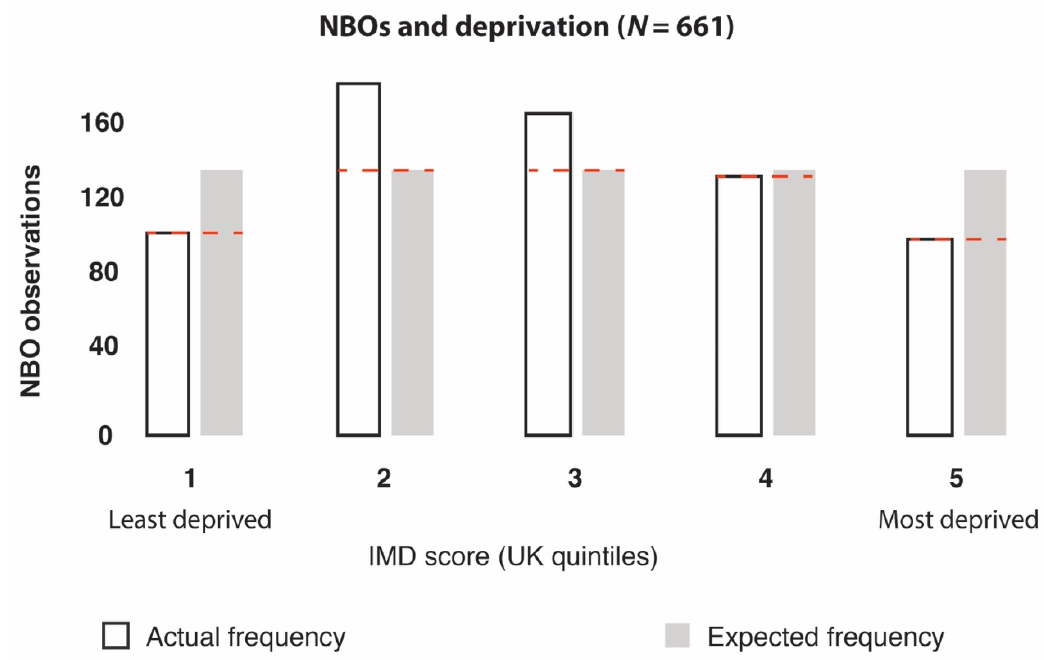
Figure 12. Output of X 2 results: The frequencies of nature-based organisations (NBOs) were significantly different between areas with different levels of deprivation (based on UK IMD quintile scores), where 1 = least deprived and 5 = most deprived. Note, n = 53 NBO records contained zero IMD data.